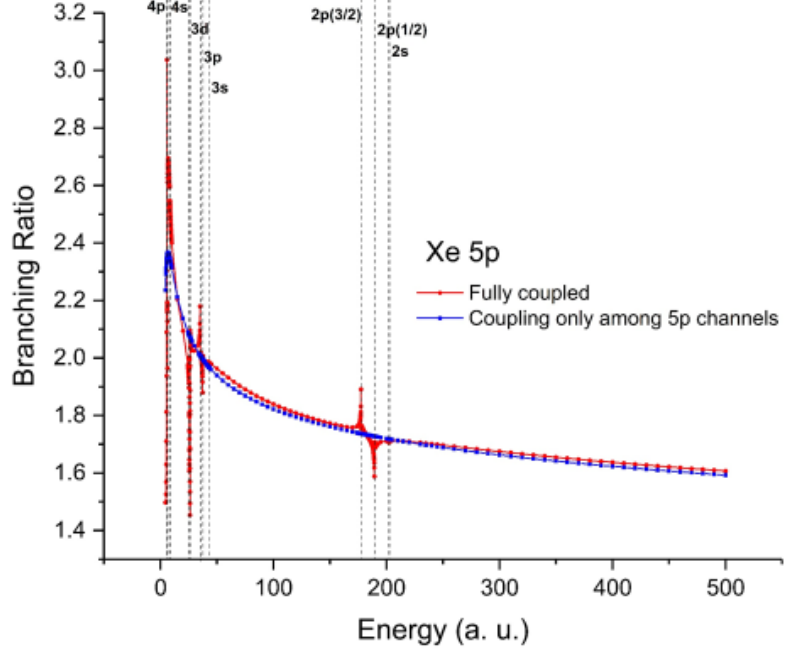
Figure 6. Photoionization cross section branching ratios for Xe 5p 3/2 /5p 1/2 calculated using RRPA with full coupling (red dots) and with only coupling among the 5p photoionization channels (blue squares) [41,42]. The vertical dashed lines indicate the